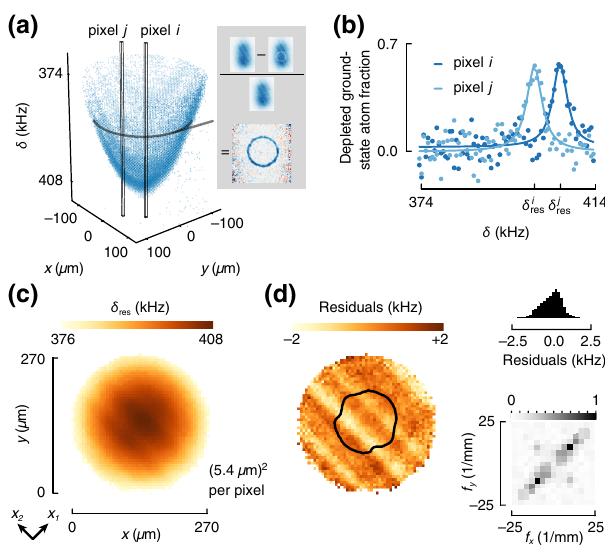
FIG. 4. Lattice envelope characterization. (a) The envelope of the lattice potential reconstructed by stacking the images of depleted g fractions obtained at different clock-laser detunings δ (left). To obtain these images, we take an image with (OD clk ) and without (OD bg ) clock excitations. For each detuning, we calcu- late the depleted g fraction ( OD bg − OD clk )/ OD bg (right). (b) For every pixel, we plot the depleted g fraction as a function of the detuning δ and extract the peak frequency δ res with a Lorentzian fit (solid lines). (c) The resulting image of δ res for every pixel in (a). The cavity axes are labeled as x 1 and x 2 . (d) When fitting the potential envelope predicted by ideal TEM 00 modes to the data in (c), we find fit residuals showing fringe patterns coaligned with the lattice axes. A histogram (peak-normalized spatial Fourier transform) of the residuals is shown in the top (bottom) right. The black contour line on the image of residuals shows the expected Mott-insulator shape, based on the envelope data in (c). The resulting shape is shown as the shaded region in Fig. 1(b). the histogram of residuals is asymmetric, as shown at the top right of Fig.